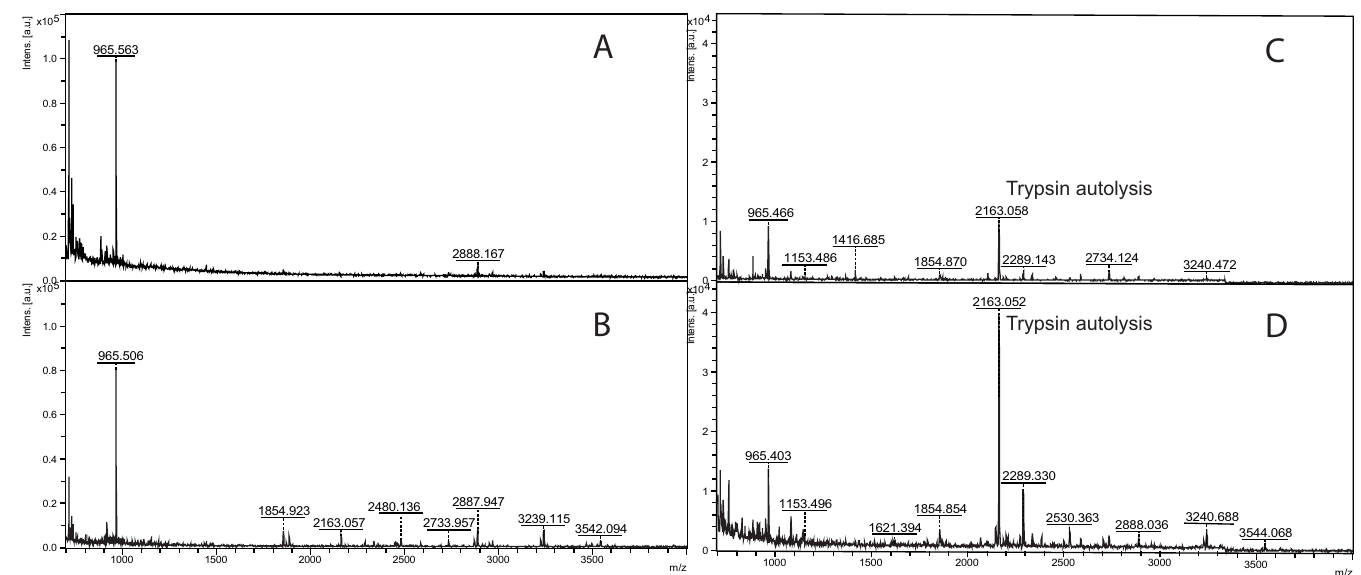
Fig 3. MALDI-MS of rhOPN trypsin digests with different molar ratio of trypsin to rhOPN. (A) 4 μ g/mL rhOPN, n trypsin : n rhOPN = 1:25, (B) 4 μ g/mL rhOPN, n trypsin : n rhOPN = 1:5, (C) 100 ng/mL rhOPN, n trypsin : n rhOPN = 5:1, (D) 100 ng/mL rhOPN, n trypsin : n rhOPN = 10:1. https://doi.org/10.1371/journal.pone.0213405.g003 (S4 Fig). On the other hand, BSA and rhOPN were strongly bound to DEAE-CB, but IgG was not bound. Thus, the depletion of IgG could be achieved by using DEAE-CB in the first step. BSA could be eluted both by Tris-NaCl pH 8.0 and PB-Gly pH 4.4, while rhOPN only appeared in the Tris-NaCl pH 8.0 fraction (Fig 4). In Fig 4 (right), the detection of rhOPN is